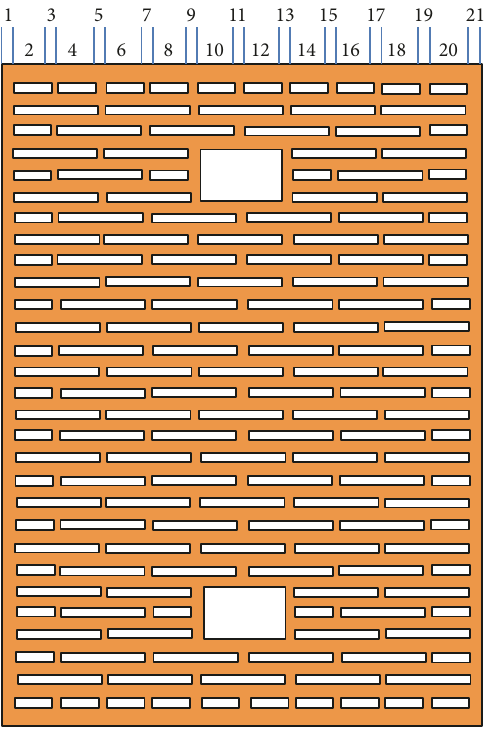
Figure 8: Area division of a hollow shale block.